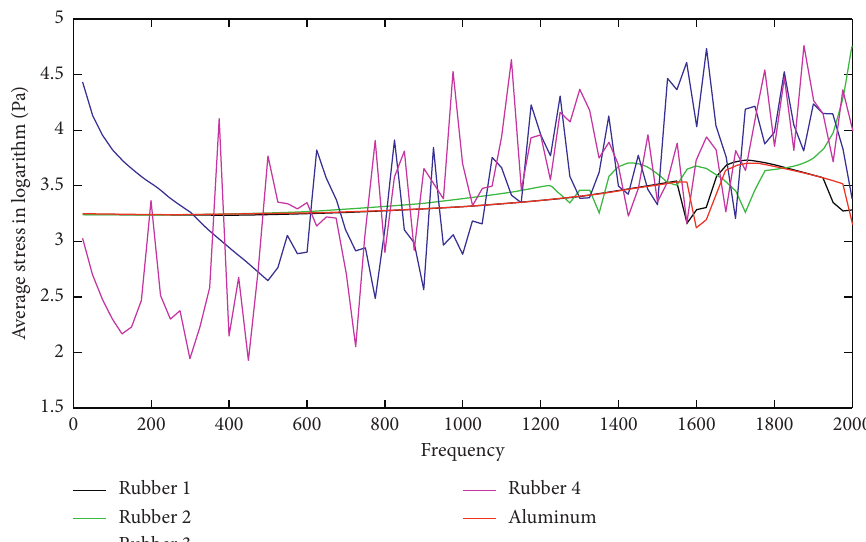
Figure 10: Absolute value of average von Mises